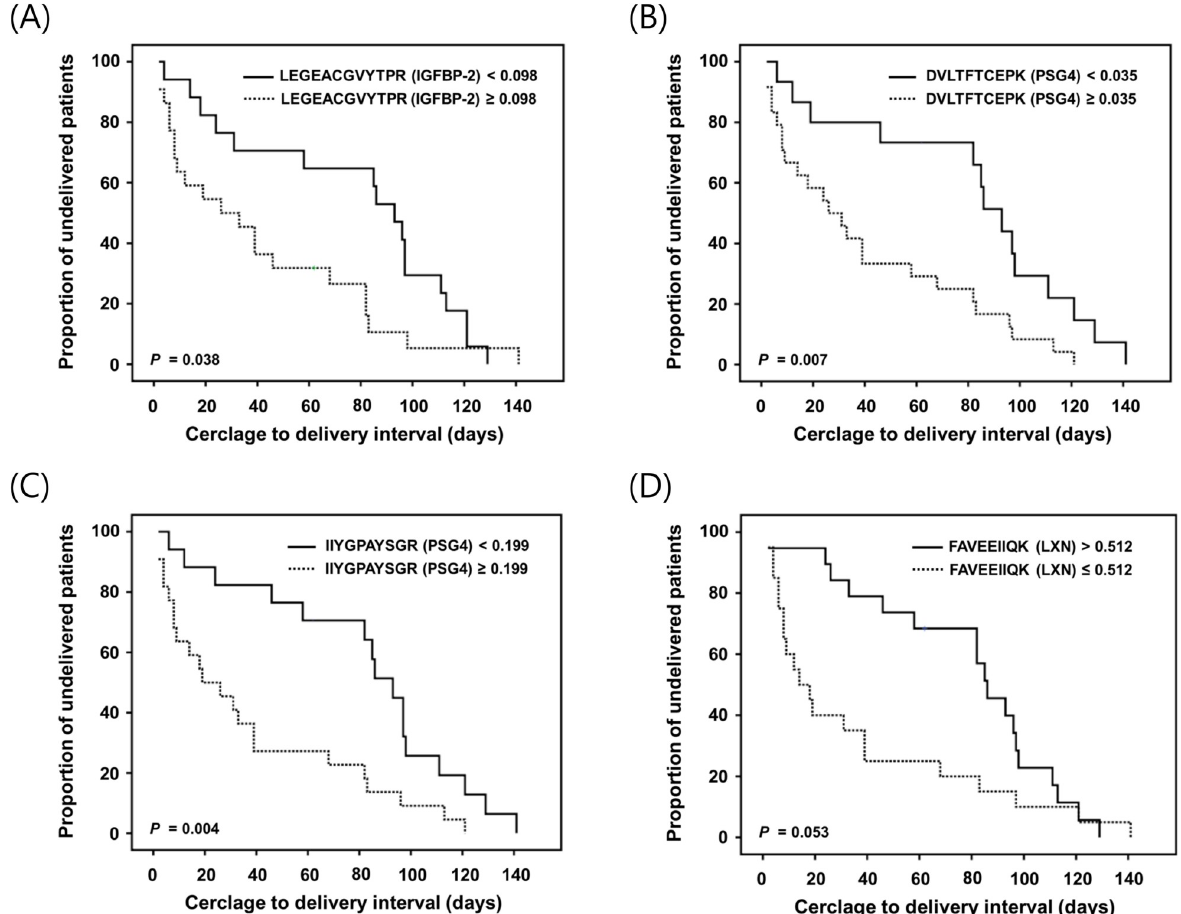
Fig 4. Kaplan-Meier survival estimates of the cerclage-to-delivery interval for (A) LEGEACGVYTPR (IGFBP-2) of � 0.098 or < 0.098 (median, 26.00 days [95% CI, 1.17–50.82] vs. 93.00 days [95% CI, 78.21–107.79]; P = 0.038), (B) DVLTFTCEPK (PSG4) of � 0.035 or < 0.035 (median, 26.00 days [95% CI, 7.99–44.00] vs. 93.00 days [95% CI, 78.81–107.18]; P = 0.007), (C) IIYGPAYSGR (PSG4) of � 0.199 or < 0.199 (median, 19.00 days [95% CI, 0.00–38.53] vs. 93.00 days [95% CI, 77.82–108.17]; P = 0.004), and (D) FAVEEIIQK (LXN) of � 0.512 or > 0.512 (median, 14.00 days [95% CI, 0.85–27.14] vs. 86.00 days [95% CI, 71.23–100.76]; P = 0.053). IGFBP, insulin-like growth factor-binding protein; CI, confidence interval; PSG, pregnancy-specific beta 1 glycoprotein; LXN, latexin.